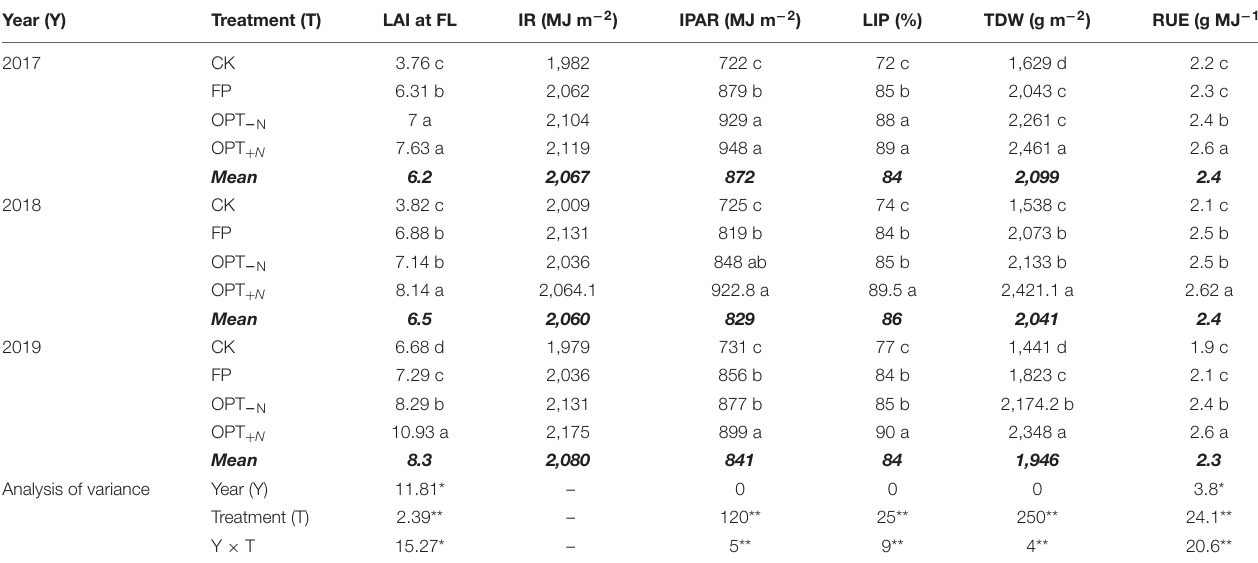
TABLE 5 | Leaf area index at FL, aboveground TDW, RUE, and related parameters at maturity for four treatments at Suizhou. Year